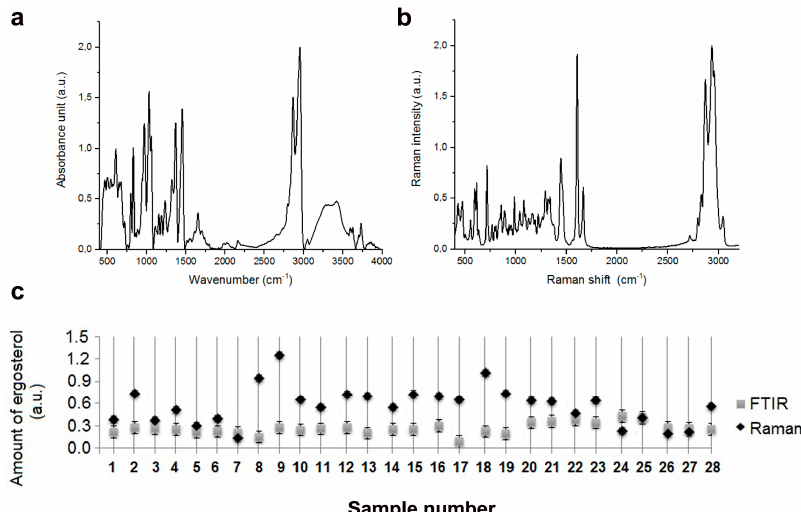
Figure 6. FTIR spectrum ( a ) and Raman spectrum ( b ) of ergosterol reference standard. ( c ) Quantitative analysis of ergosterol content in clinical Candida isolates based on both FTIR and Raman spectroscopy. C. albicans group (1, 2, and 4–19), C. tropicalis group (20, 21), C. glabrata group (3 and 22–25), 302 haploid reference strain (26), SC5314 diploid strain (27), and T15 tetraploid strain (28). Bars indicate SD, n = 3, a.u., arbitrary